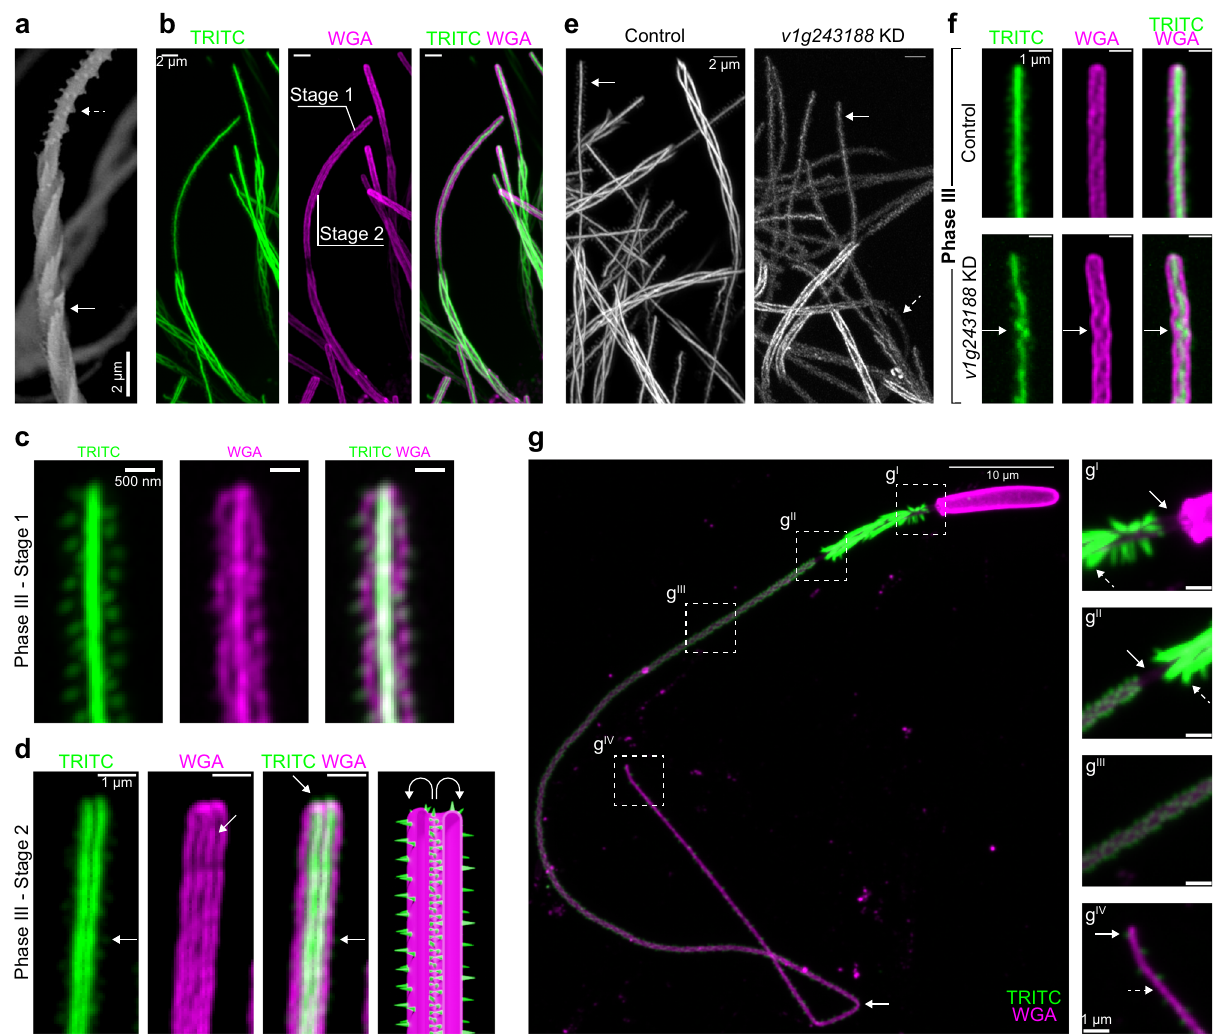
Fig. 3 The mechanism of tubule eversion. a SEM image ( n = 6, 2 experiments) of the shaft (arrow), tubule, and helically arranged barbs (dashed arrow). b Fluorescent image of a partially everted tubule. The shaft fi laments and barbs (TRITC, green) and the thread wall (WGA, magenta) are shown ( n = 10 primary polyp tentacles, 3 experiments). Scale bars 2 μ m. c Super-resolution image of the everting tubule tip (Stage 1) ( n = 20 threads of a primary polyp tentacle). The barbs (TRITC, green), the tubule (WGA, magenta), combined channels are shown. Scale bars 0.5 μ m. d The tip of an everting tubule (Stage 2) ( n = 8/30 double-walled threads of a primary polyp tentacle). The tubule wall (magenta), its double-walled structure (left middle panel, arrow), and the barbs (right middle panel, arrow) are shown. Illustration of Stage 2 (right panel). Scale bars 1 μ m. e Structure of the tubule barbs (arrows) in scramble control ( n = 0/20 partially discharged threads of a primary polyp tentacle) and v1g243188 ( n = 20/20 partially discharged threads of a primary polyp tentacle) shRNA KD samples (dashed arrow). Brightness was adjusted to visualize the v1g243188 threads. Scale bars 2 μ m. f Effects of the scramble and v1g243188 knockdown on the barbs (TRITC, green) and tubule wall (WGA, magenta). The arrows indicate the disorganized barbs ( n = 25/25 threads compared to scramble ( n = 0/25 threads). Brightness was adjusted to visualize the v1g243188 threads. Representative of partially discharged threads from primary polyp tentacles (Scramble, n = 27 primary polyp tentacles; v1g243188 , n = 25 primary polyp tentacles, n = 5 shRNA knockdown experiments). Scale bars 1 μ m. g A fully everted thread labeled with TRITC and WGA ( n = 15 puri fi ed and discharged threads). Arrow indicates kinking at a distal tubule site. g I Capsule-shaft connector (arrow) and the everted shaft (green, dashed arrow). g II The shaft-tubule connector (arrow), and the everted shaft (dashed arrow). g III Fully everted tubule wall (magenta) and the barbs (green). g IV Tip of the thread showing the tubule wall (magenta, dashed arrow) sparsely decorated with barbs (green,